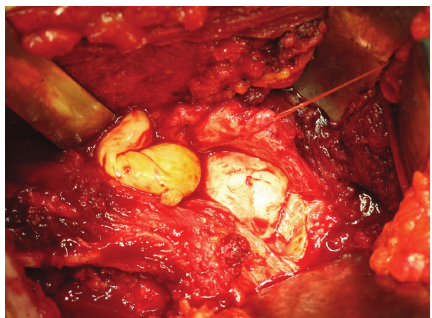
Figure 2: Excision of the synovial tumor using the Ganz surgical dislocation